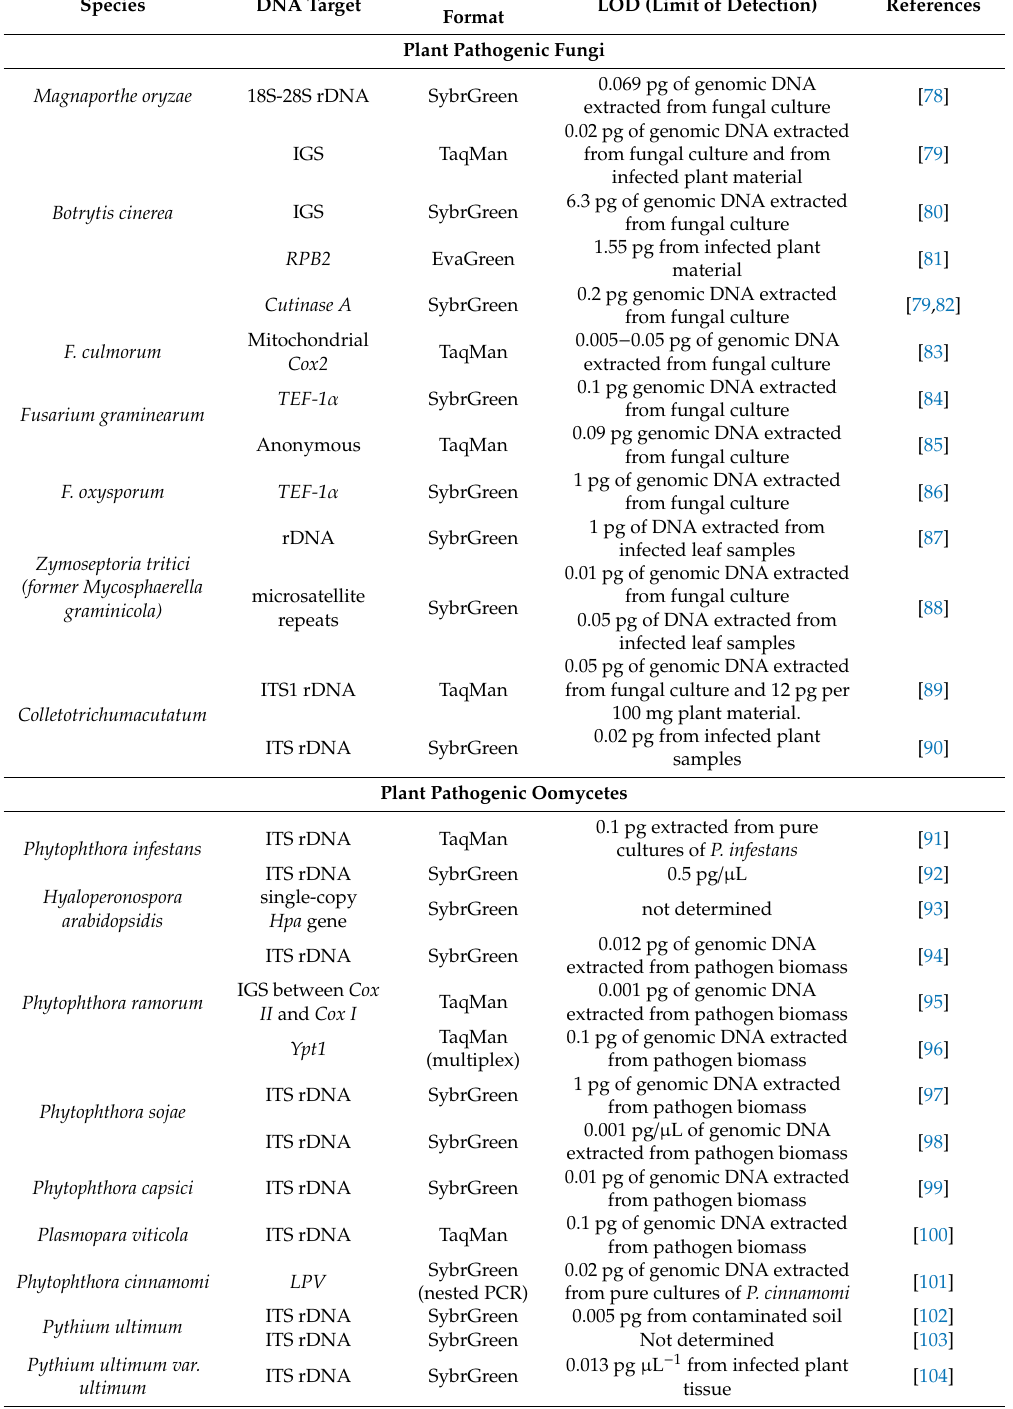
Table 1. Examples of species-specific quantitative polymerase chain reaction (qPCR) approaches for morphologically defined plant pathogenic fungi and oomycetes of the highest scientific and economic importance